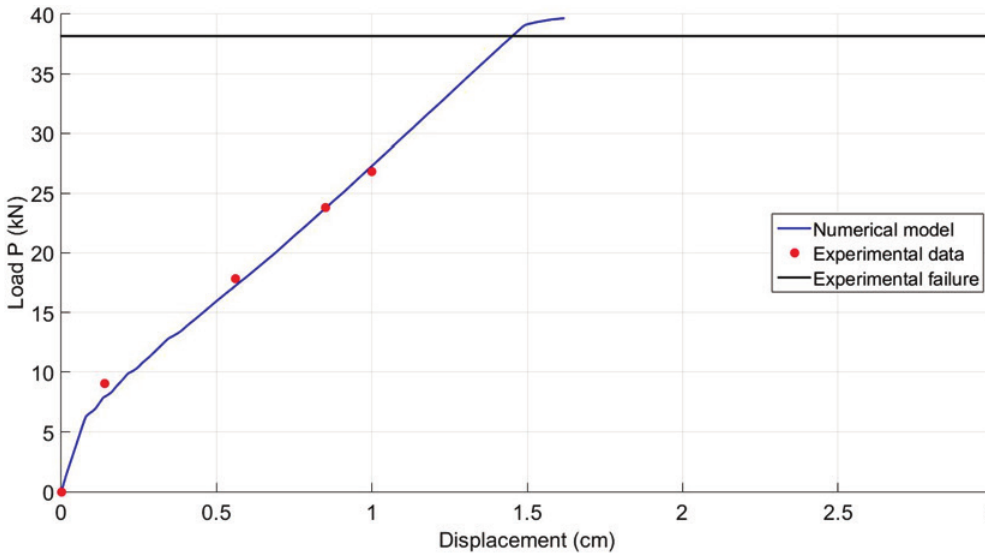
Figure 4.4 Load-displacement plot for the specimen RC-100-1